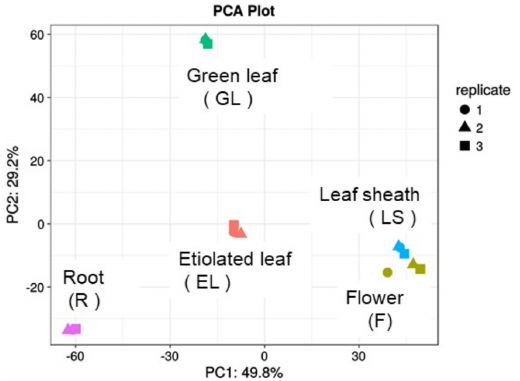
Figure 3. PCA of the total proteome data from the plasma membranes of five organs. We have presented the data of 15 samples, including triplicate samples of five organs, namely, the root (R), etiolated leaf (EL), green leaf (GL), leaf sheath (LS), and flower (F). The raw data were analyzed using MaxQuant to identify and quantify proteins, using in-house standard parameters.